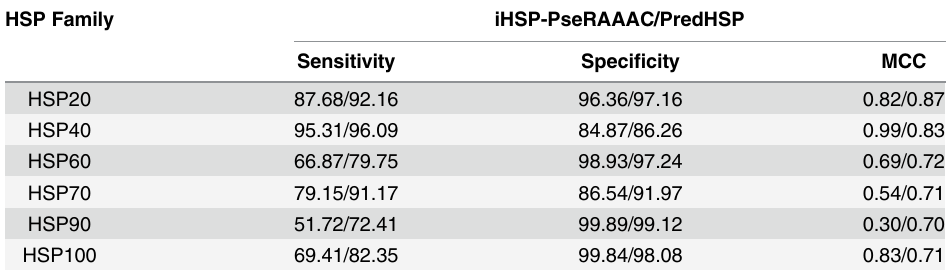
Table 5. Comparison of performance of PredHSP with iHSP-PseRAAAC at 2 nd tier. HSP Family